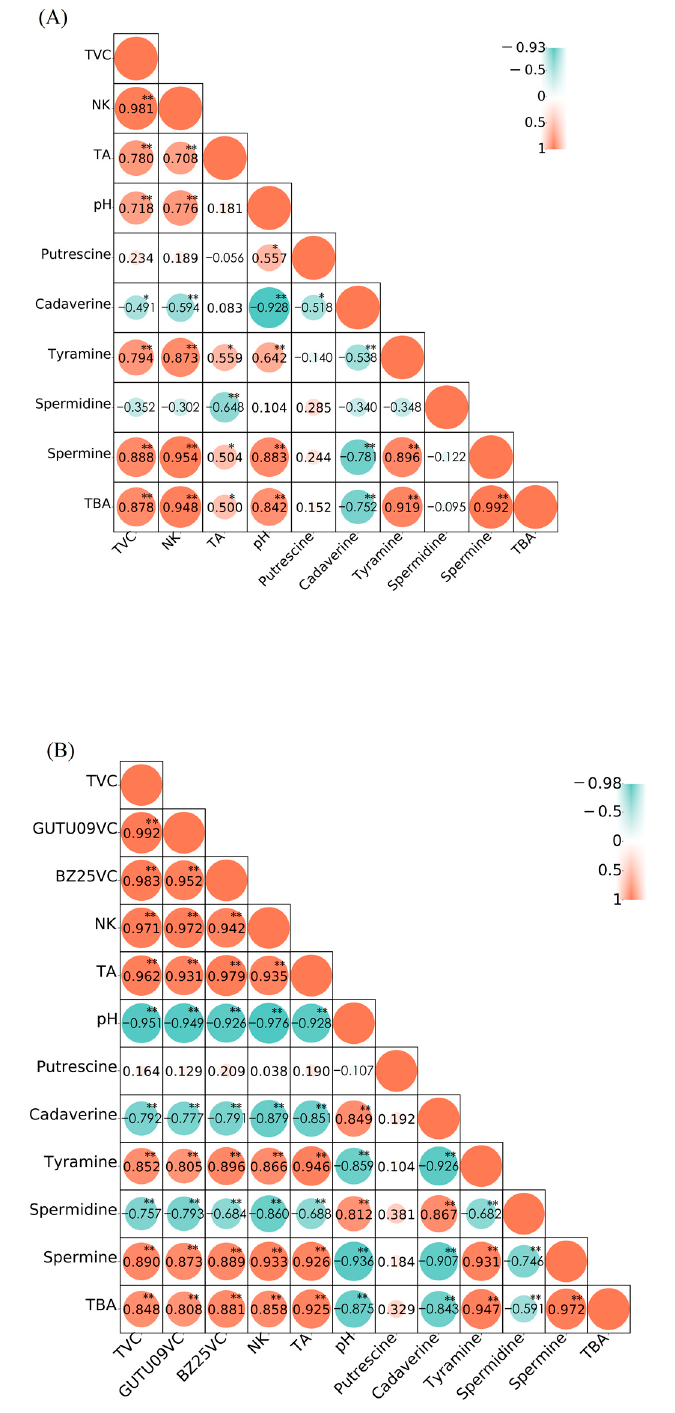
Figure 6. Pearson correlation coefficients between different indexes in natto. NMB ( A ); NMBB ( B ); GUTU09VC refers to the viable count of GUTU09 in the NMBB; BZ25VC refers to the viable count of BZ25 in the NMBB. TVC: total viable count; NK: nattokinase; TA: titratable acidity; “*” p < 0.05 was significantly different; “**” p < 0.01 was extremely significantly different.